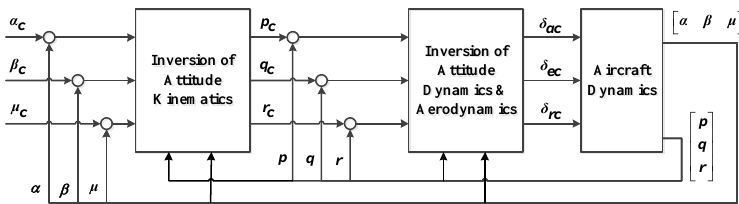
Figure 3. Configuration of the baseline nonlinear dynamic inversion (NDI) controller.